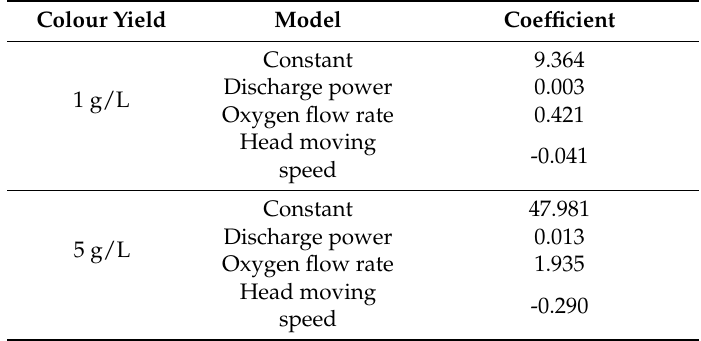
Table 9. Coefficient of the regression models of yellow pigment-dyed colour